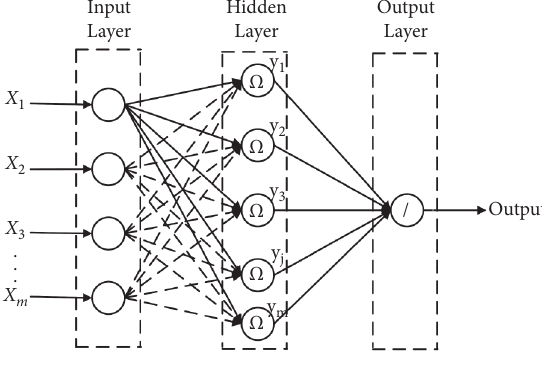
Figure 7: Architecture of RBFN algorithm.